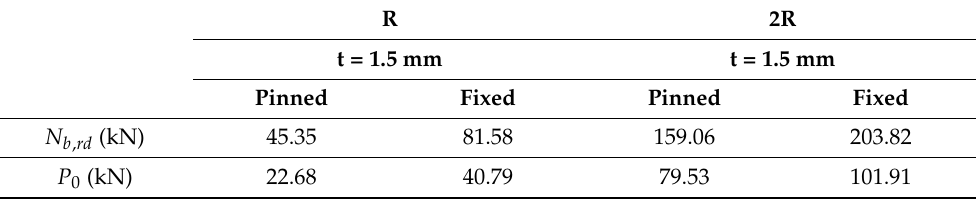
Table 1. Predicted values for CFS columns ( N b , Rd ) and applied service loads ( P 0